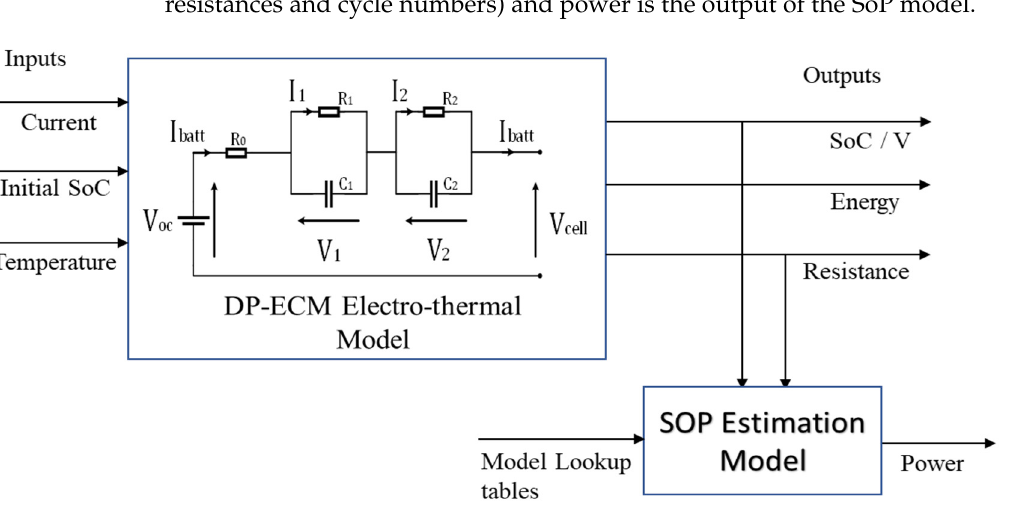
Figure 8. Capacitance 2 as a function of temperature and state of charge.